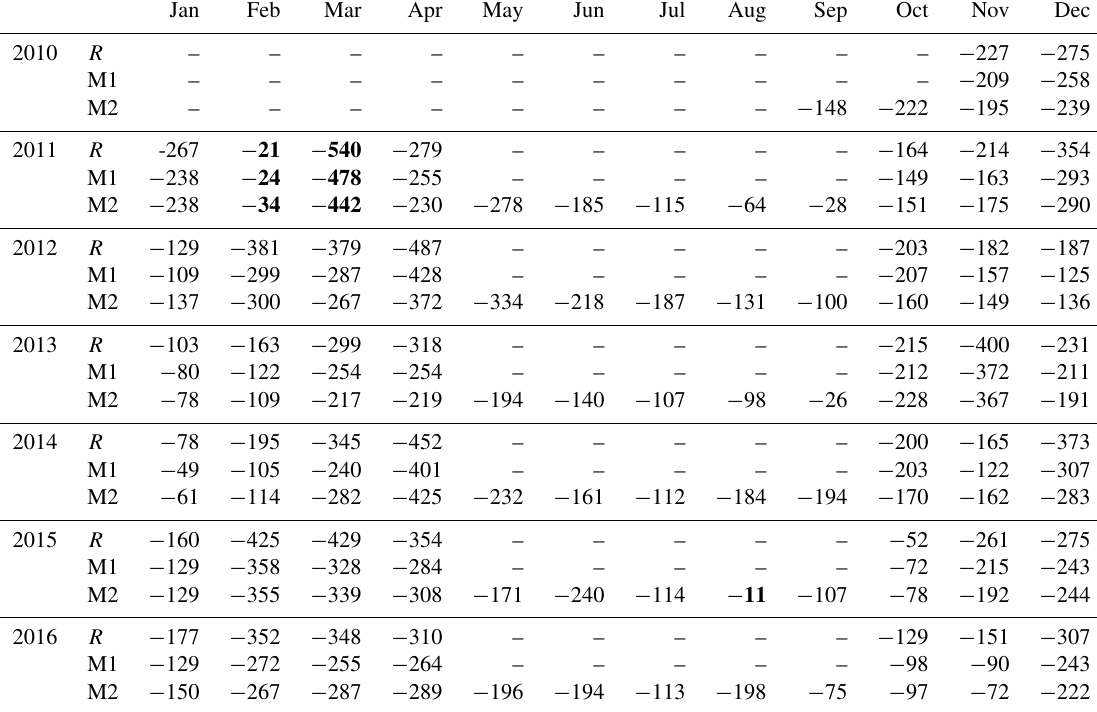
Table 2. Monthly Arctic sea ice volume export through the Fram Strait in cubic kilometers per month. Note that R is calculated by CS2 thickness and OSI SAF drift, M1 is calculated by CMST thickness and OSI SAF drift, and M2 is calculated by CMST thickness and CMST drift. The bold values represent the minimum and maximum values in this